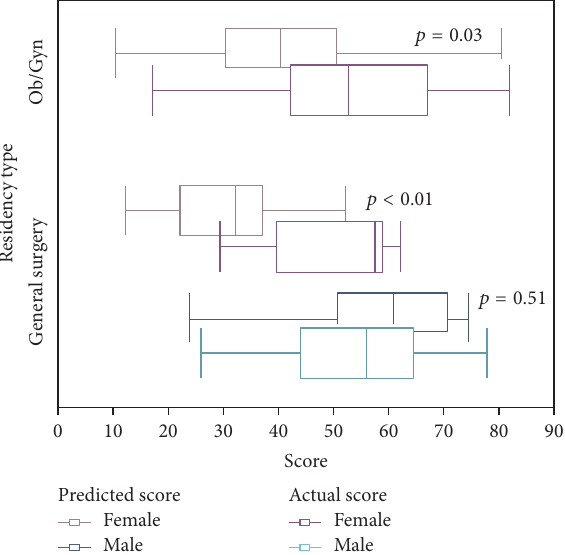
Figure 1: Predicted and actual scores by residency type and gender. 𝑝 values depicted on the figure represent delta scores (difference between predicted and actual score) within the